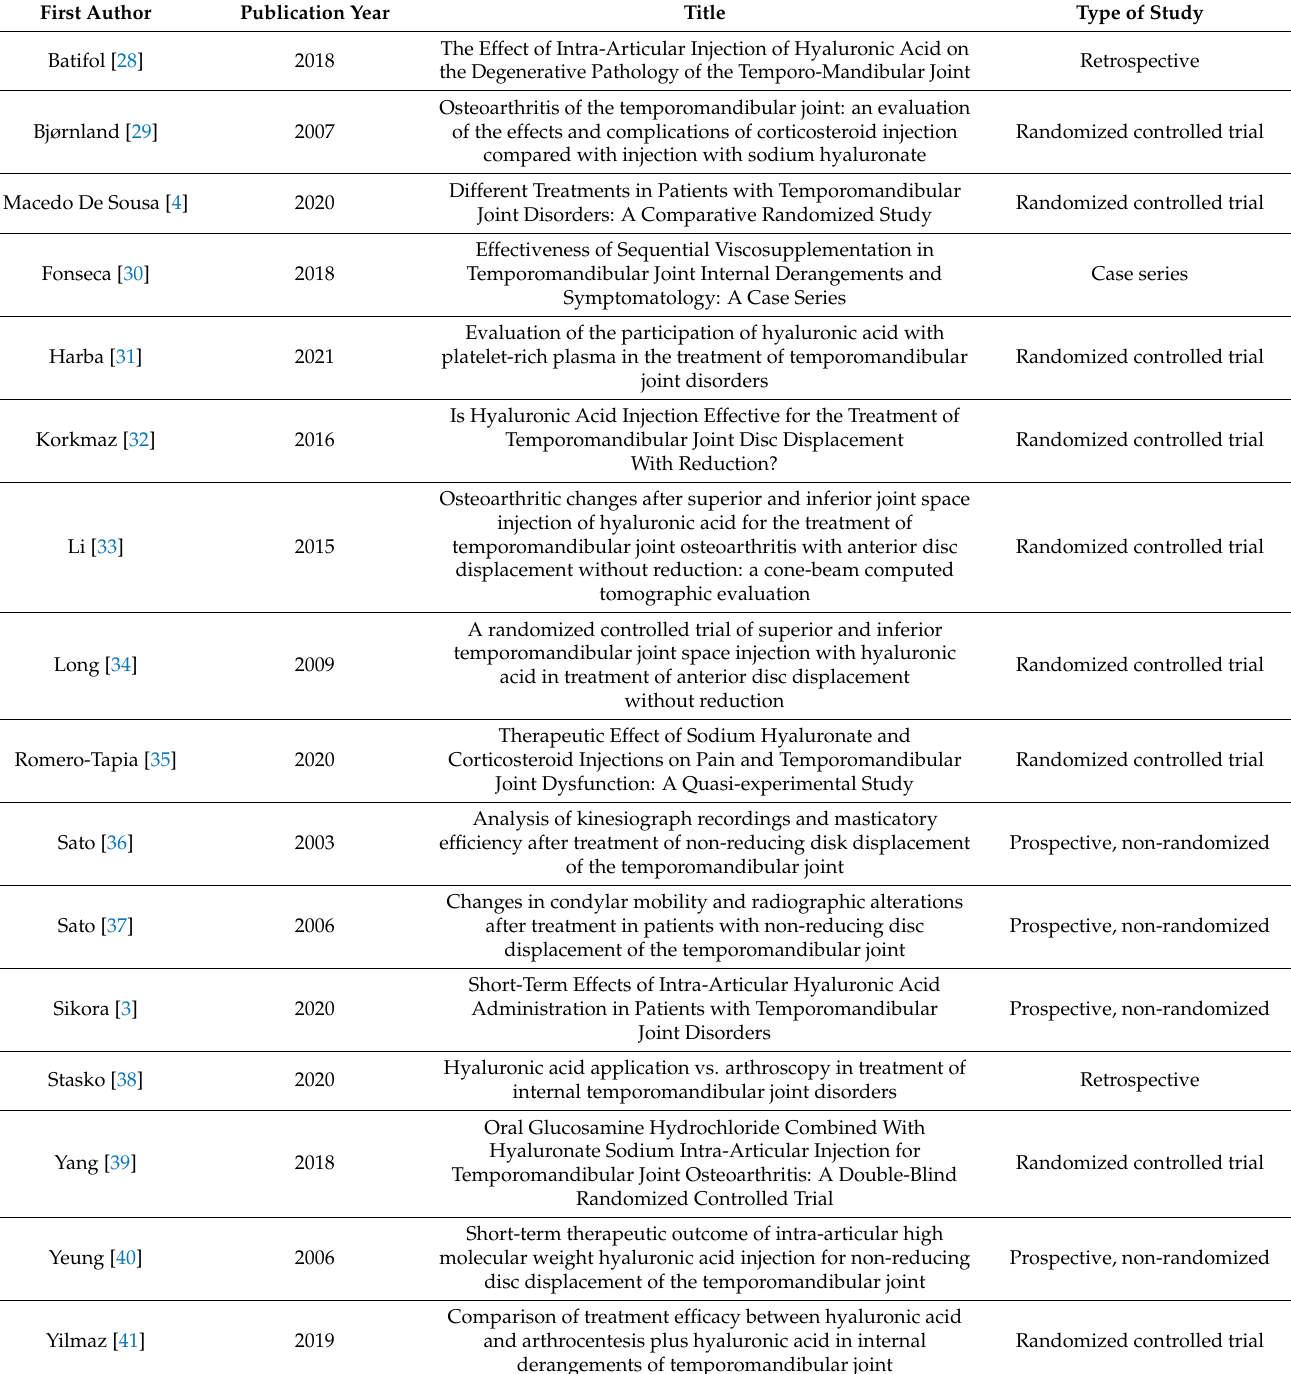
Table 3. Reports describing studies that meet the eligibility